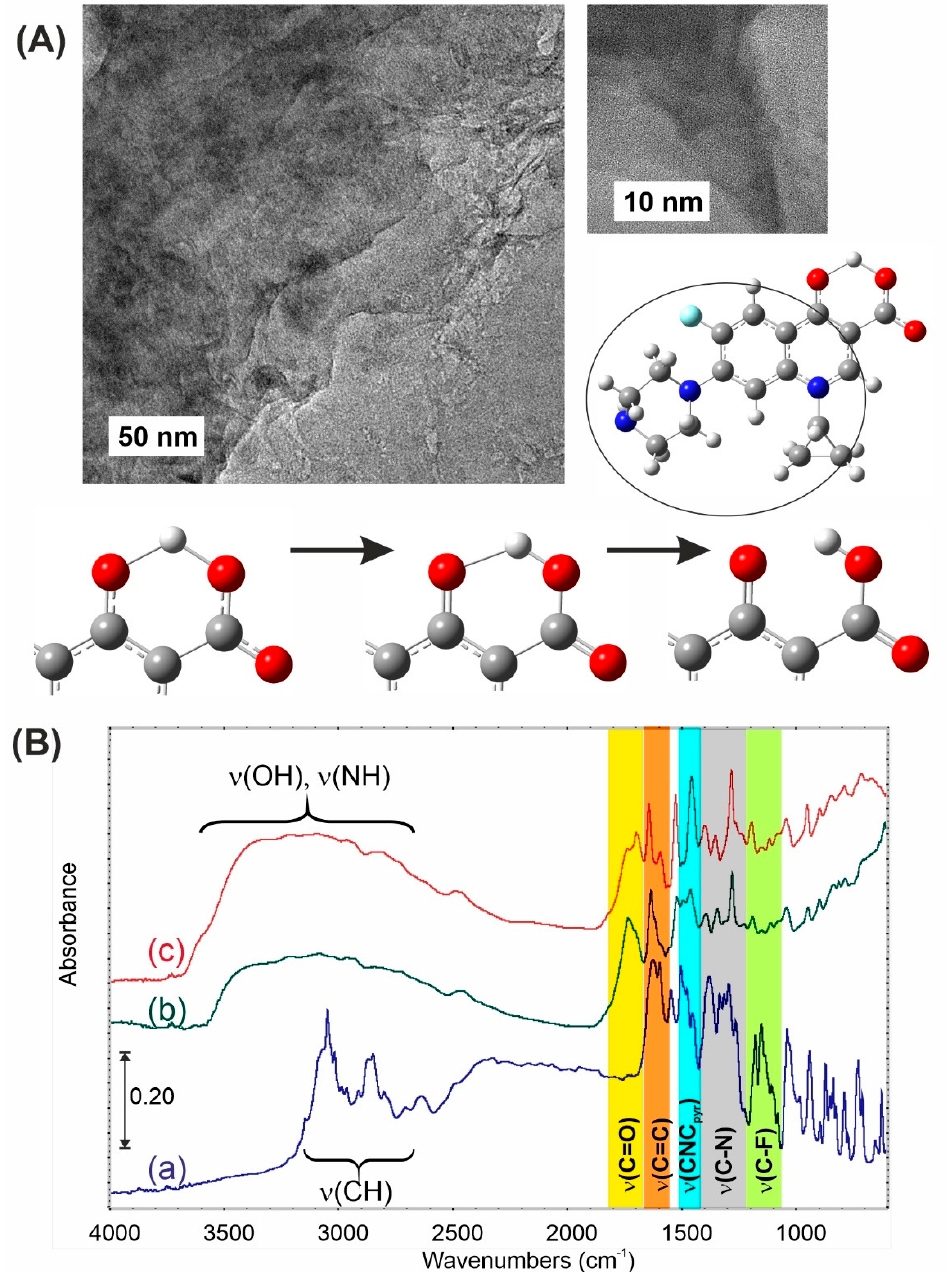
Figure 3. ( A ) HRTEM pictures of CIP:GO 1:1. ( B ) FTIR spectra of pure CIP: (a) and in complex with GO: (b) 1:2, (c) 1:1; with the scheme showing CIP internal salts destruction. The circle denotes the part